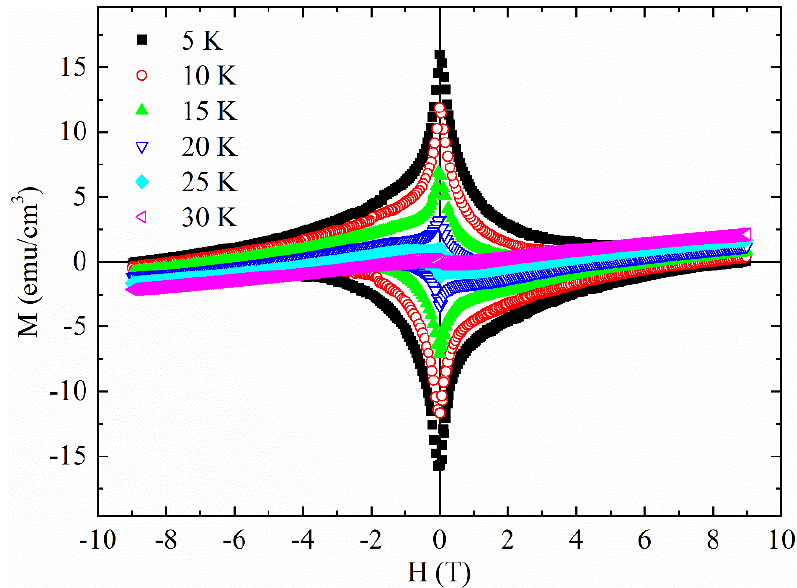
Figure 2. Magnetization versus field at different temperatures below T c .